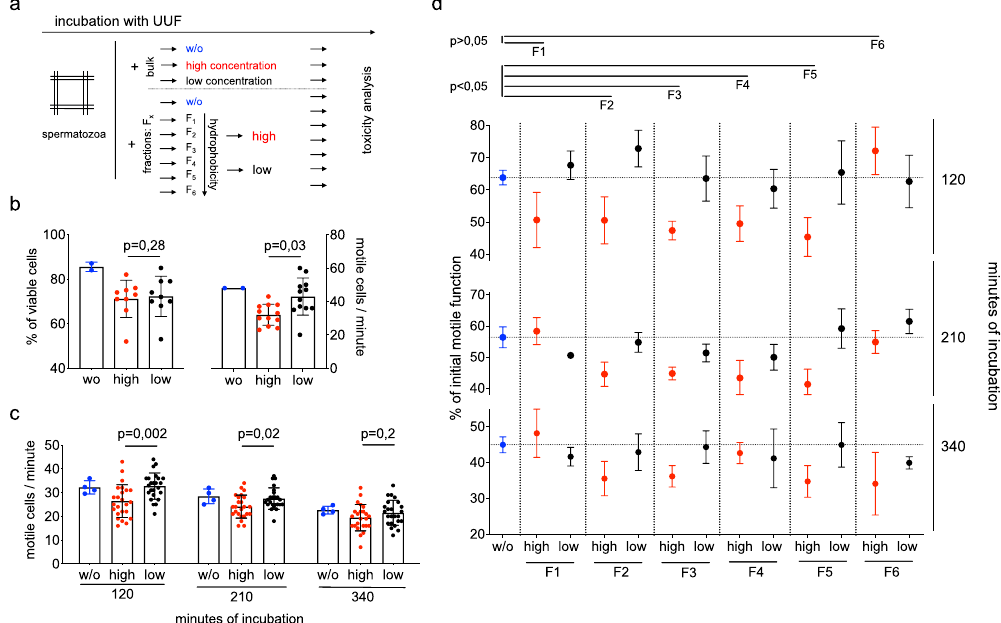
Figure 2. Toxicity detection of uremic ultrafiltrate (UUF). (a) Workflow of two experimental approaches. UUF collected from patients during high-flux hemodialysis and prepared by elution into fractions (F). F1 is most hydrophilic and F6 most hydrophobic fraction, respectively. (b) High (1:1 dilution of UUF) and low concentration (1:16 dilution of UUF) of bulk UUF were applied in nine independent experiments for viability testing and 12 independent experiments for motility testing. Cells were gained from one donor and incubated for one minute. Two controls (w/o) were applied. (c) High and low concentration of UUF tested on motility long-term outcome. 12 independent experiments on cells from two donors, respectively. For each donor, two independent controls were applied (w/o). (d) Fractions (F1-F6) tested for toxicity by comparing high (red) vs. low (black) concentration after 120, 210 and 340 minutes of incubation. Mean shows two experimental series on cells from two donors on two conditions (high and low), respectively. Doubled controls were applied for each series (w/o, blue). Tickled line shows medium value of internal control. Bars in (d) present SEM. P-value indicates significance